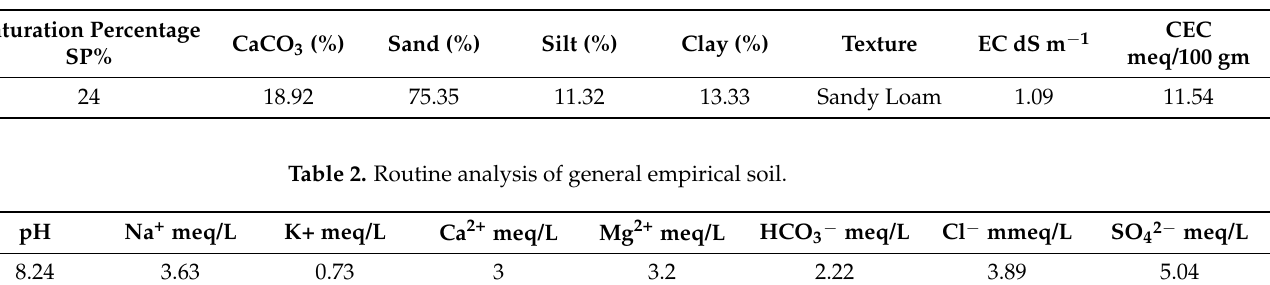
Table 2. Routine analysis of general empirical soil.